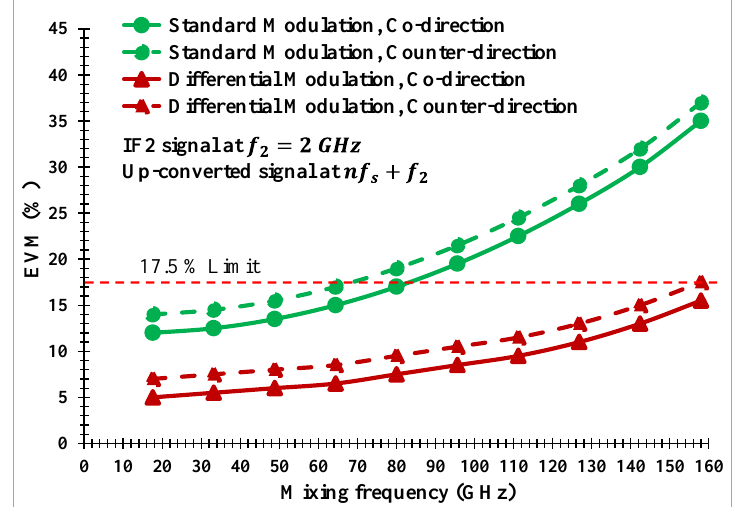
Figure 15. EVM of up-converted QPSK signals from f 2 = 2 GHz to the mixing frequencies nf s + f 2 at the bit rate of 100 Gbit/s for the four cases.